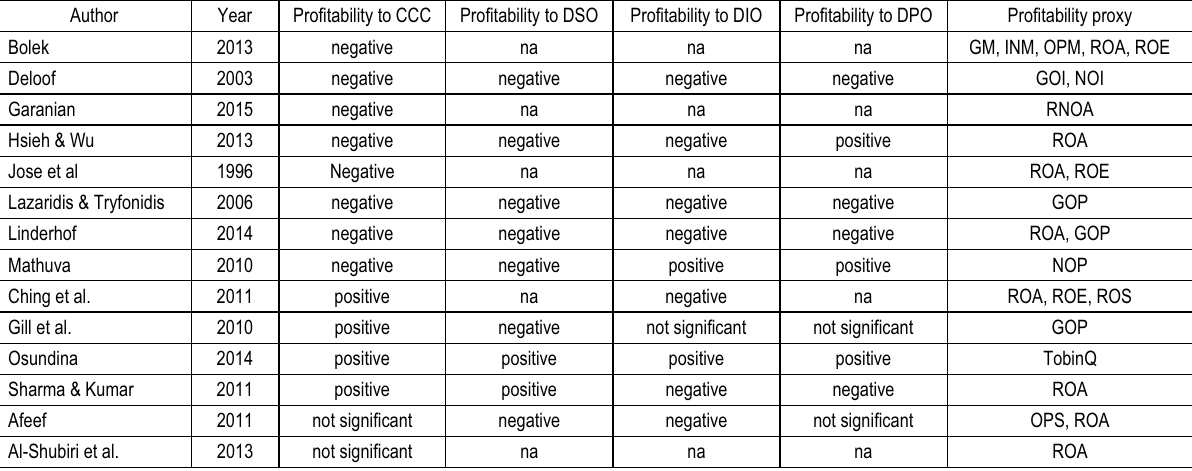
Table 1. Summary of